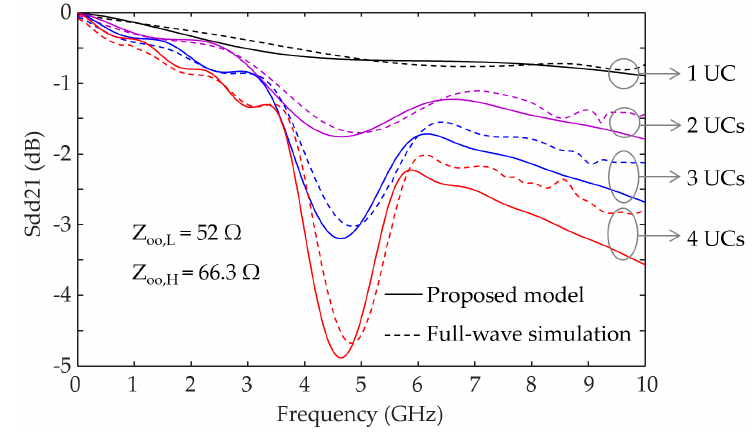
Figure 8. Differential signal transmission characteristics with varying number of UCs for model verification.